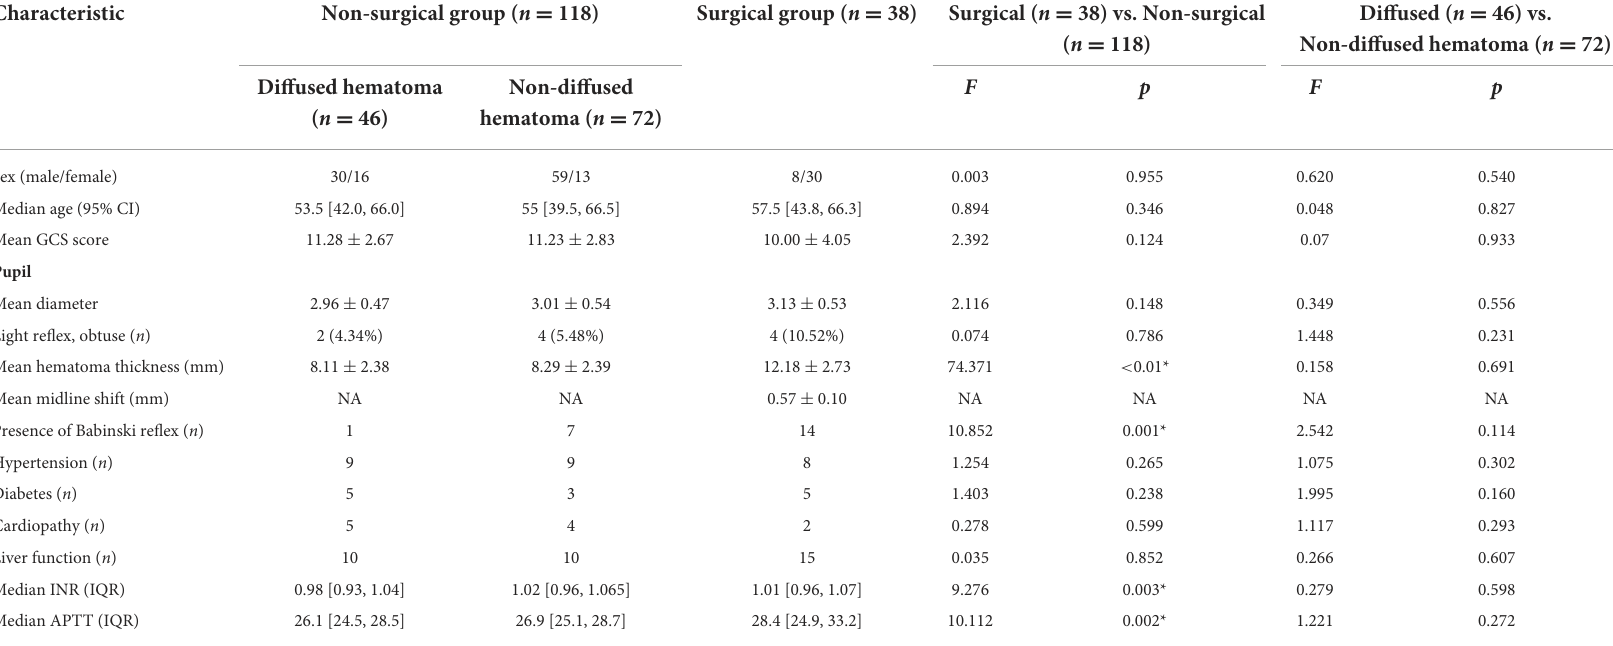
TABLE 1 Demographic characteristics of the enrolled patients (total n = 156, non-surgical group n = 118, surgical group n = 38). Characteristic Non-surgical group ( n = 118) Surgical group ( n = 38) Surgical ( n = 38) vs. Non-surgical